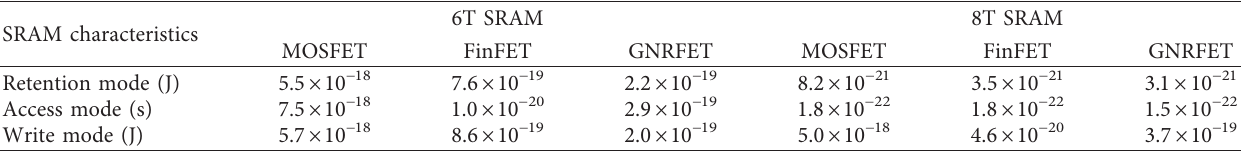
Table 7: Analysis of power-delay-product of MOSFET-, FinFET-, and GNRFET-based technology. SRAM